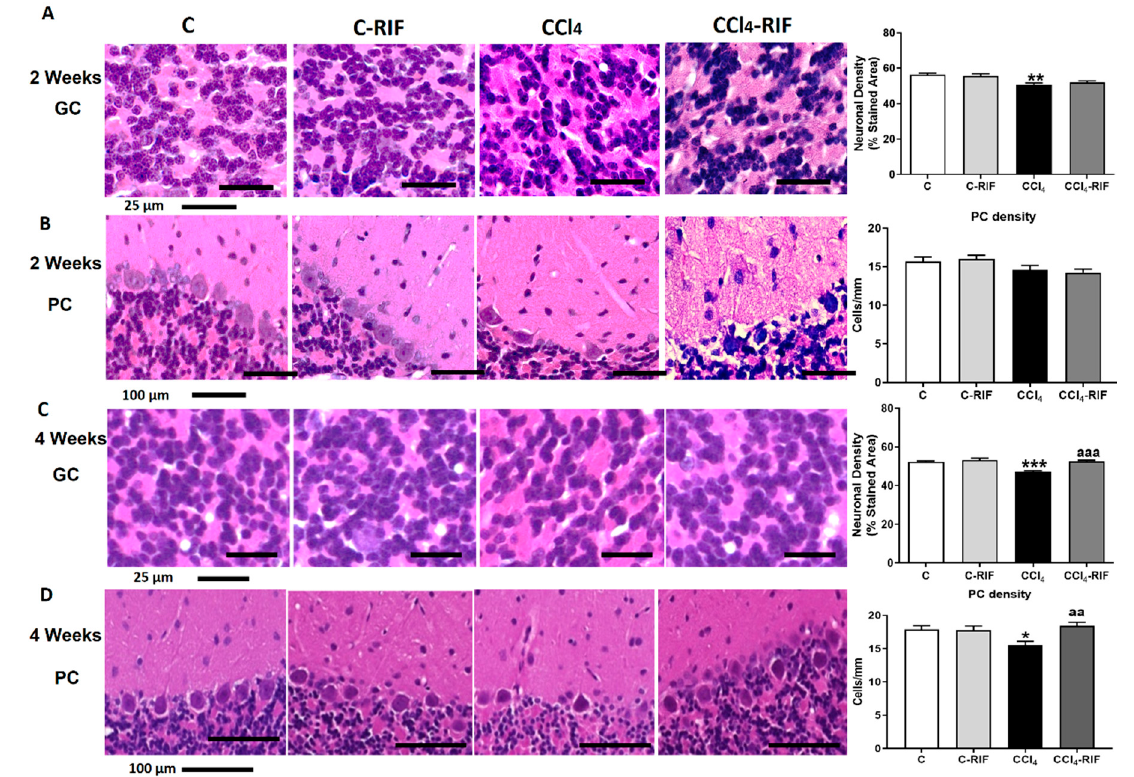
Figure 10. Rats with mild liver damage show neuronal loss in granular layer from 2 weeks and Purkinje neurons at 4 weeks. Representative images and neuronal density quantification of granular neurons ( A , C ) and Purkinje cells ( B , D ) of cerebellum stained with H&E. Values are mean ± SEM of 4–6 rats per group. One-way ANOVA with Tukey’s test for granule neurons (F(3,18) = 13.25, p < 0.0001) and Purkinje cells (F(3,16) = 2.425, p > 0.05) at 2 weeks was performed. Kruskal–Wallis with Dunn’s test for granule neurons (K-W(4,11) = 38.84, p < 0.0001) and Purkinje neurons (K-W(4,19) = 10.47, p < 0.05) at 4 weeks was performed to compare all groups. Values significantly different from control rats are indicated by asterisks and from CCl 4 rats by a. * p < 0.05, ** p < 0.01, *** p < 0.001, aa p < 0.01, aaa p < 0.001.